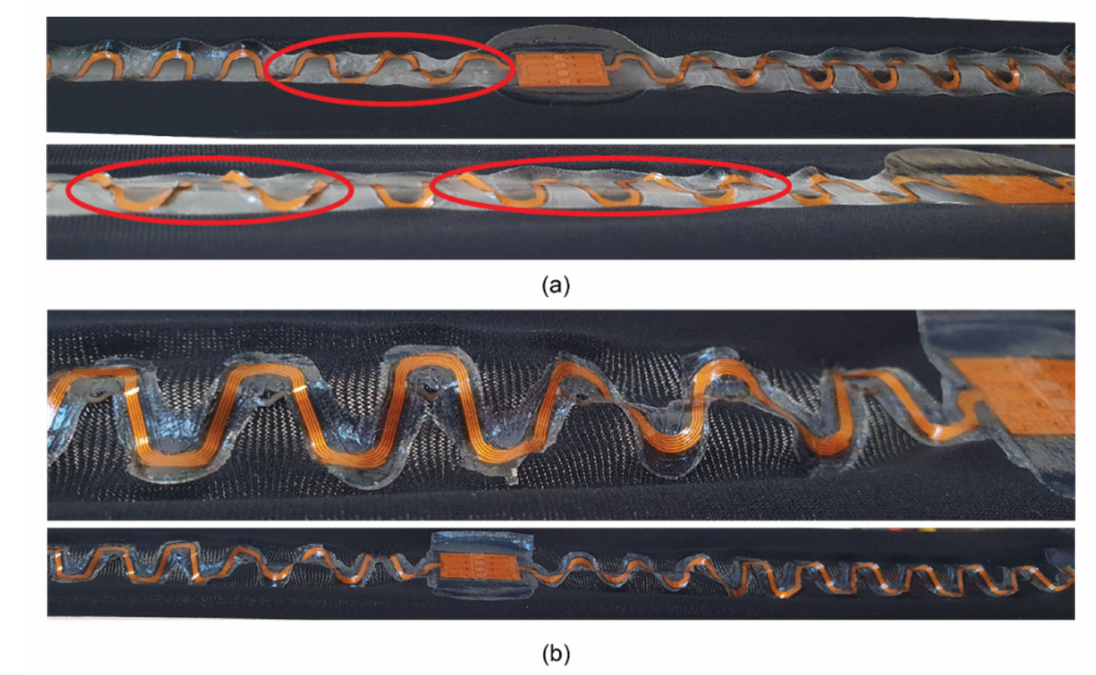
Figure 10. ( a ) V4 under 20% stretch, circled areas highlight buckling. ( b ) V1 under 20% stretch,